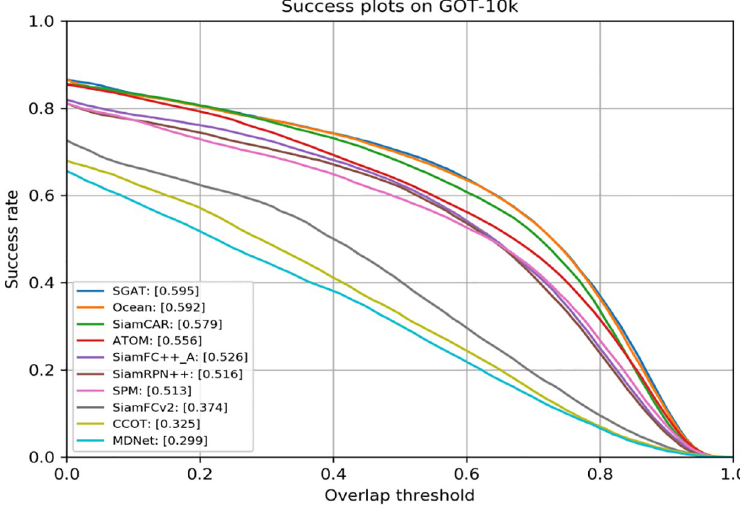
Fig 5. Comparison with other state-of-the-art trackers on the GOT-10k benchmark, the proposed tracker SGAT achieve the best tracking performance. A in SiamFC++_A indicates that the backbone network AlexNet.